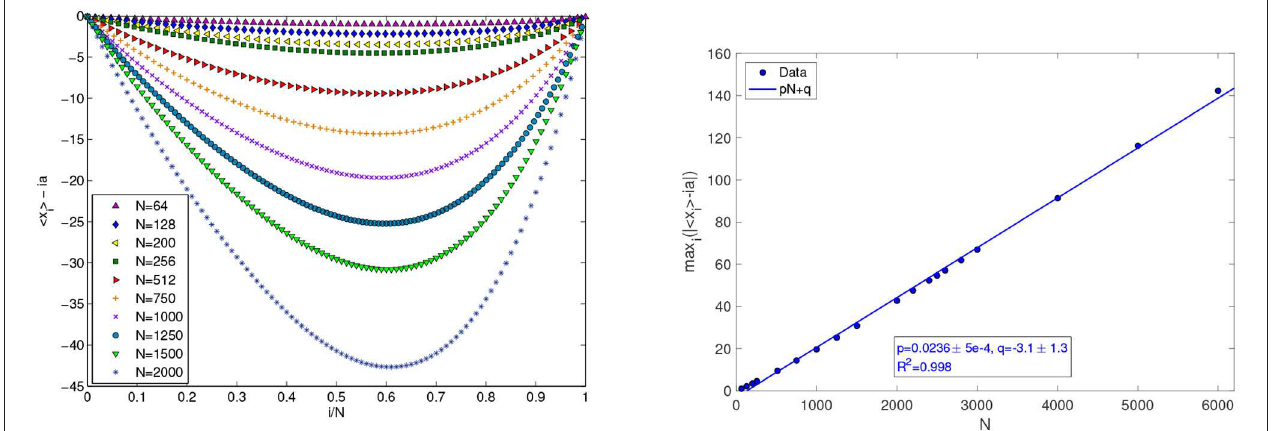
x i ia ), for different values of N , for first and h i − x i ia ) as h i − 0.6063 N 6.804 with = −